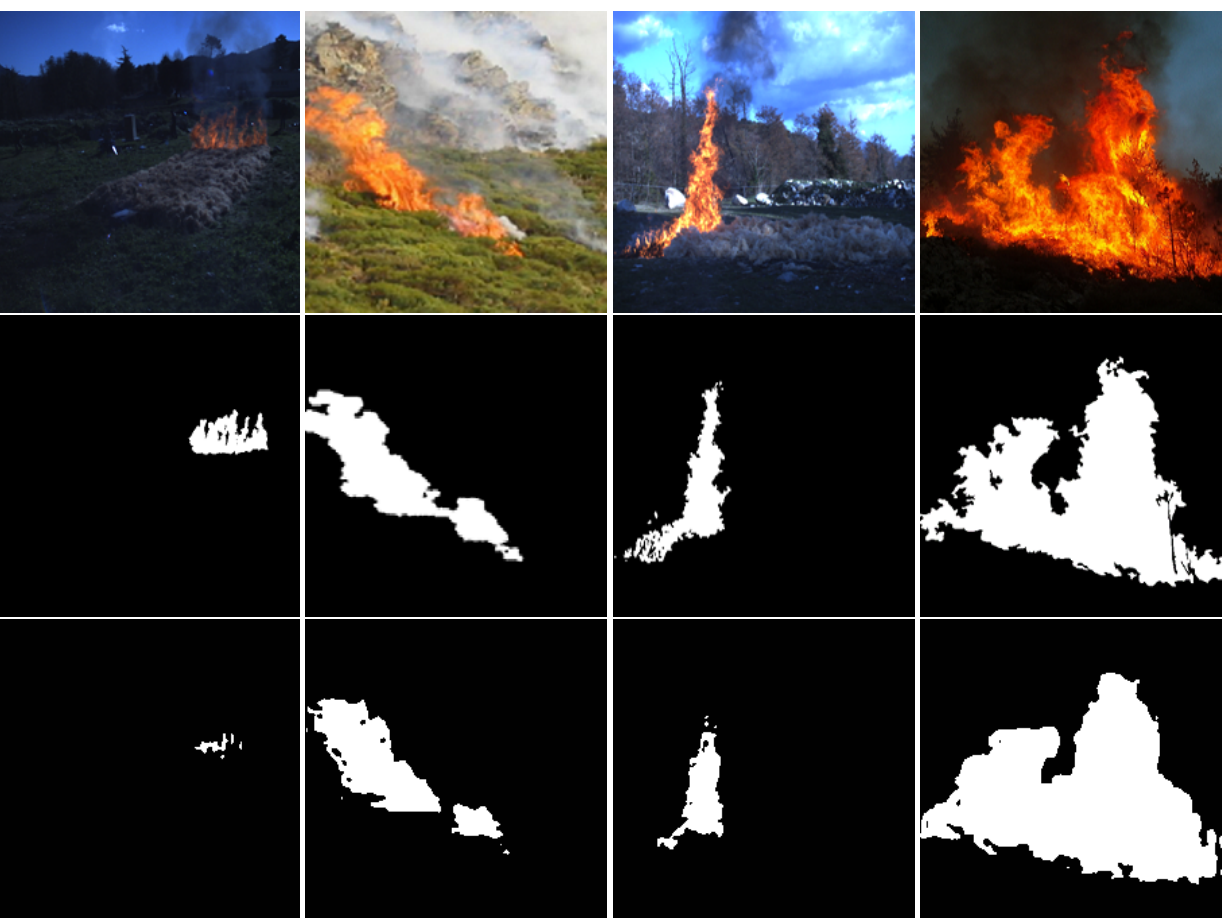
Figure 11. Results of EfficientSeg. From ( top ) to ( bottom ): RGB images, their corresponding mask, and the predicted images of